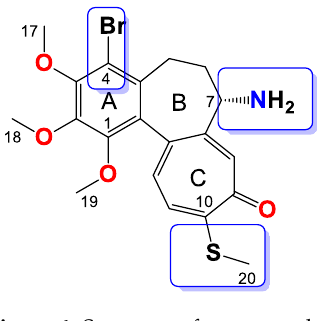
Figure 4. Structure of compound 4 .